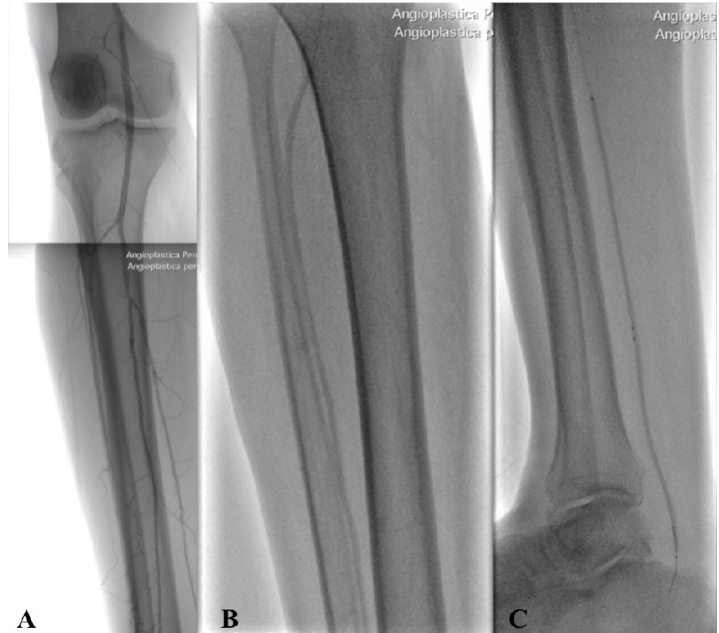
Figure 4. Intraoperative angiography showing popliteal and BTK arteries after PTA ( A ) with Balloon in Anterior Tibial Artery ( B ) and Posterior Tibial Artery ( C ).